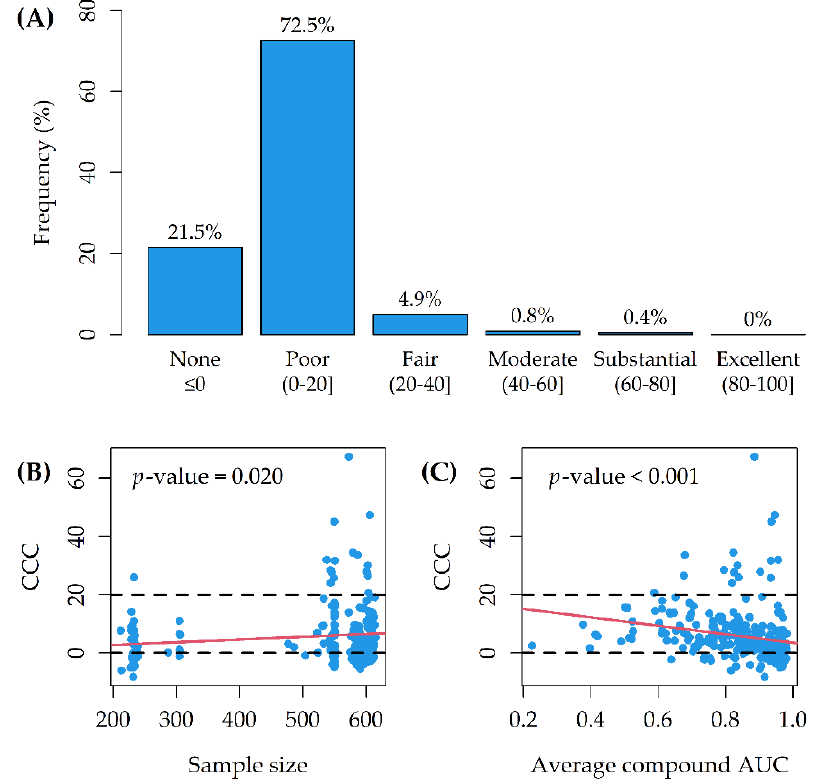
Figure 4. ( A ) Concordance correlation coefficient (CCC) distribution through the 265 Random Forests; ( B ) CCC as a function of sample size; ( C ) CCC as a function of average compound AUC. The p -values are from linear regressions (red lines). Dashed lines correspond to the thresholds of no concordance (CCC = 0) and fair concordance (CCC =